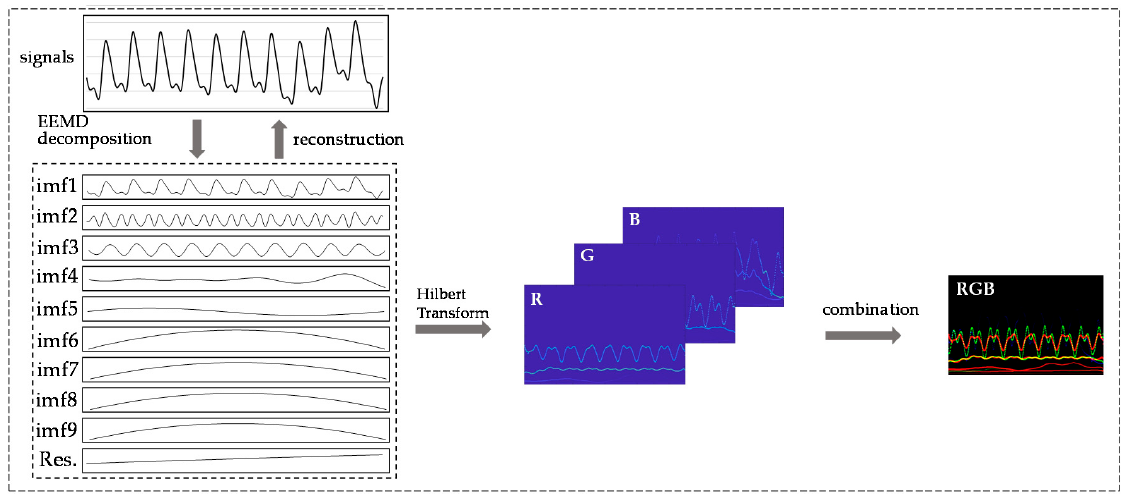
Figure 3. Process of processing PPG signal and its derivatives by the HHT (Hilbert–Huang transform) method.